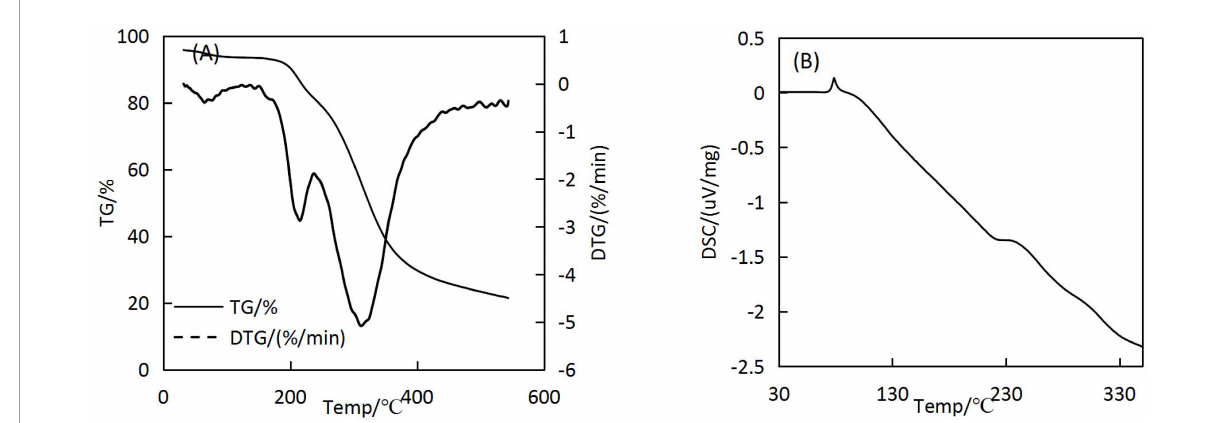
FIGURE7 TG-DTG (A) and DSC (B) curves of microcapsules.